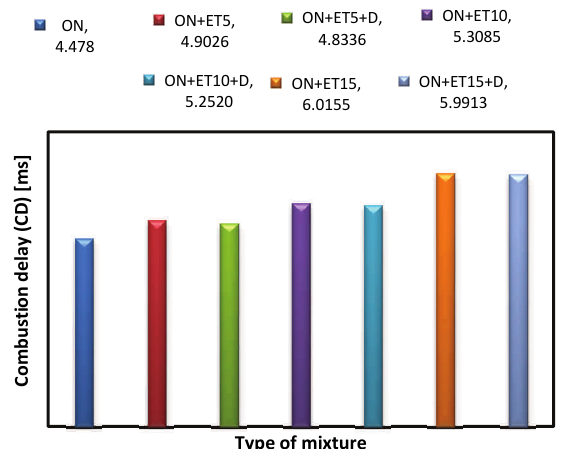
Fig. 6. Combustion delay (CD) values for blends